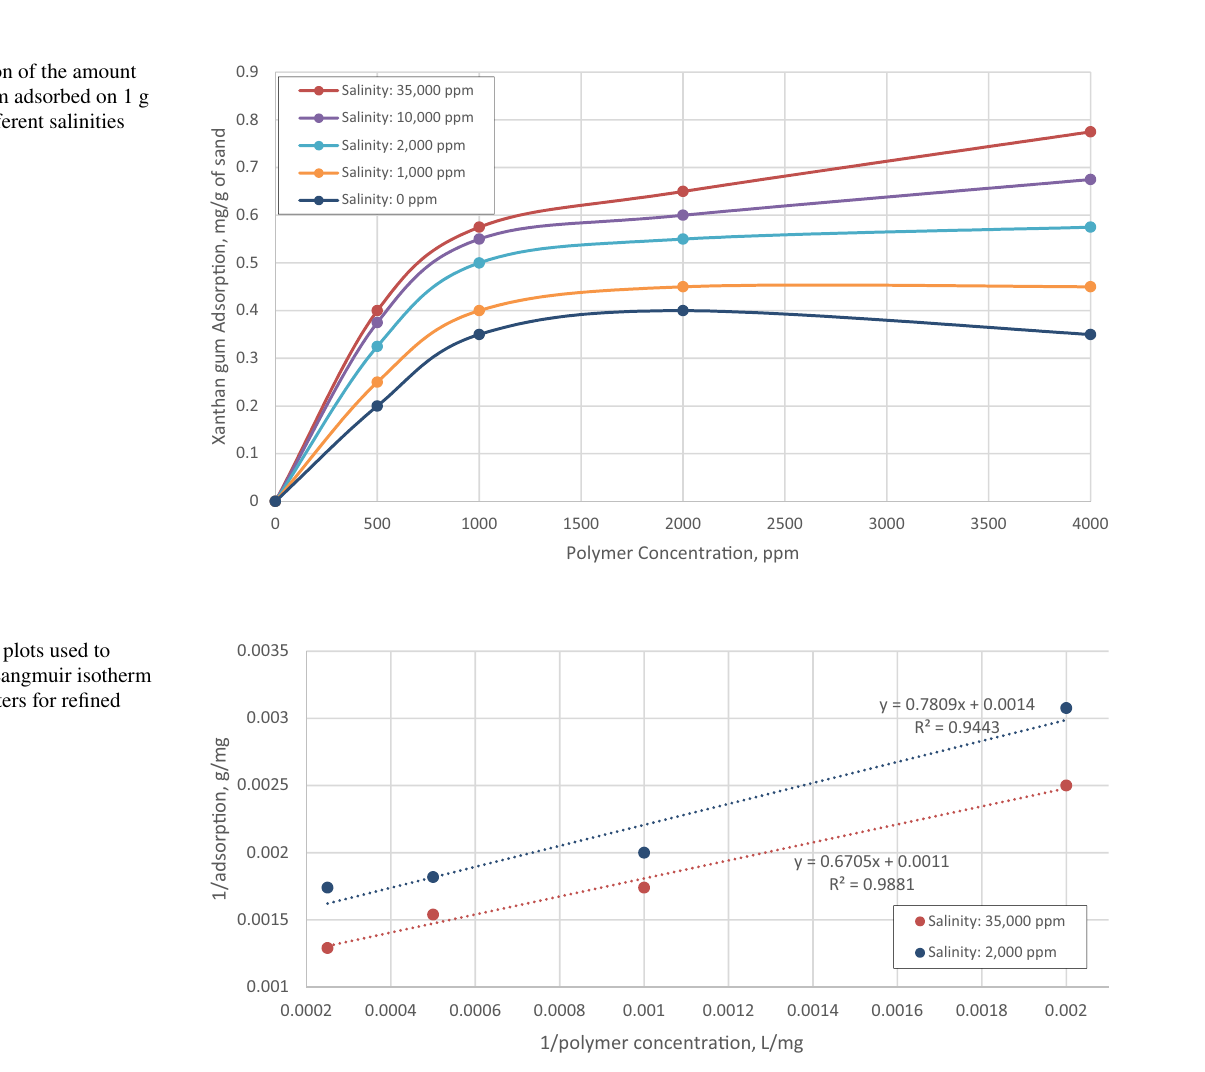
NaCl were used for the combined low salinity water and gel model, and those for the 35,000 ppm NaCl were used for the combined high salinity and gel model.